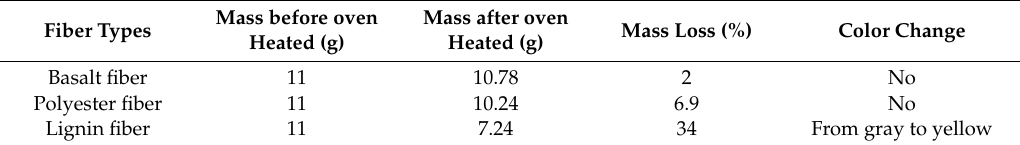
Table 6. Thermostability for three kinds of fibers.